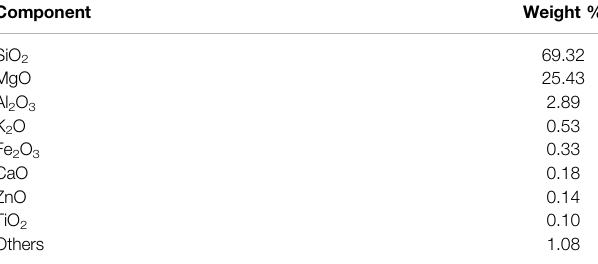
TABLE 1 | Chemical composition of Sep used in the study.